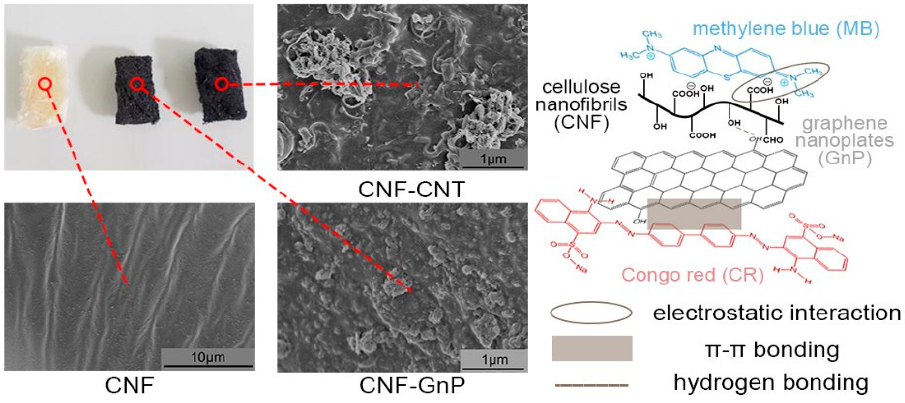
Figure 10. Mechanism of CNF-GNP hybrid aerogels for removal of cationic and anionic dyes